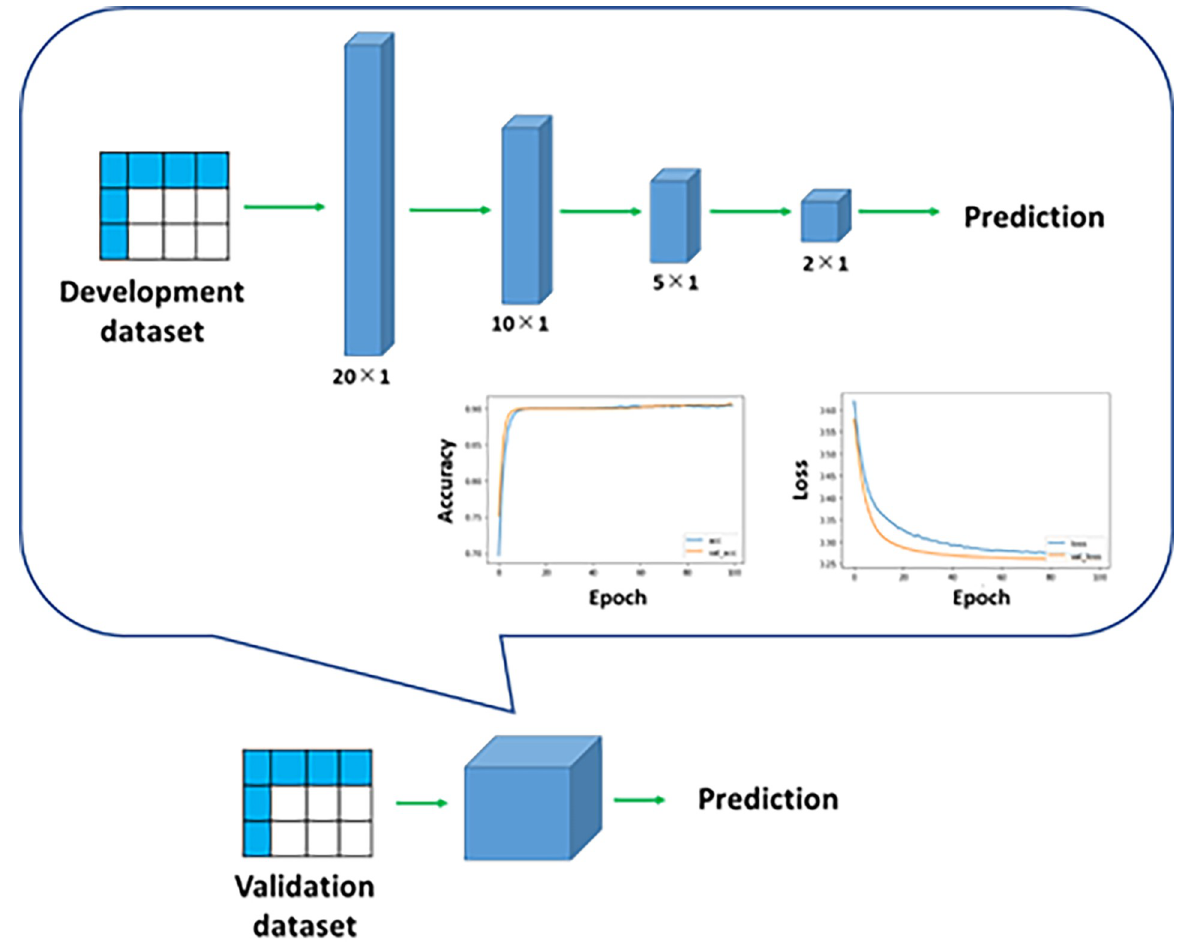
Fig 3. Deep learning model for prediction of 1-year death. The models for the prediction of 1-year and 5-year deaths were composed of multiple layers: 1 input layer; 2 or 4 hidden layers, respectively; and 1 output layer. Data of a patient were treated as 1 vector of 20 dimensions. Through the hidden layers, the patient’s characteristics were extracted. The dropout rate of each hidden layer was determined appropriately. Adam was used as a learning rate optimization algorithm. ReLUs were used as the activation function of hidden layers, and the logistic activation function was used in the output layer. The performance of a deep learning model was evaluated in terms of accuracy and loss function. The trained model was applied to the validation dataset. https://doi.org/10.1371/journal.pone.0233491.g003 PLOS ONE | https://doi.org/10.1371/journal.pone.0233491 May 29,